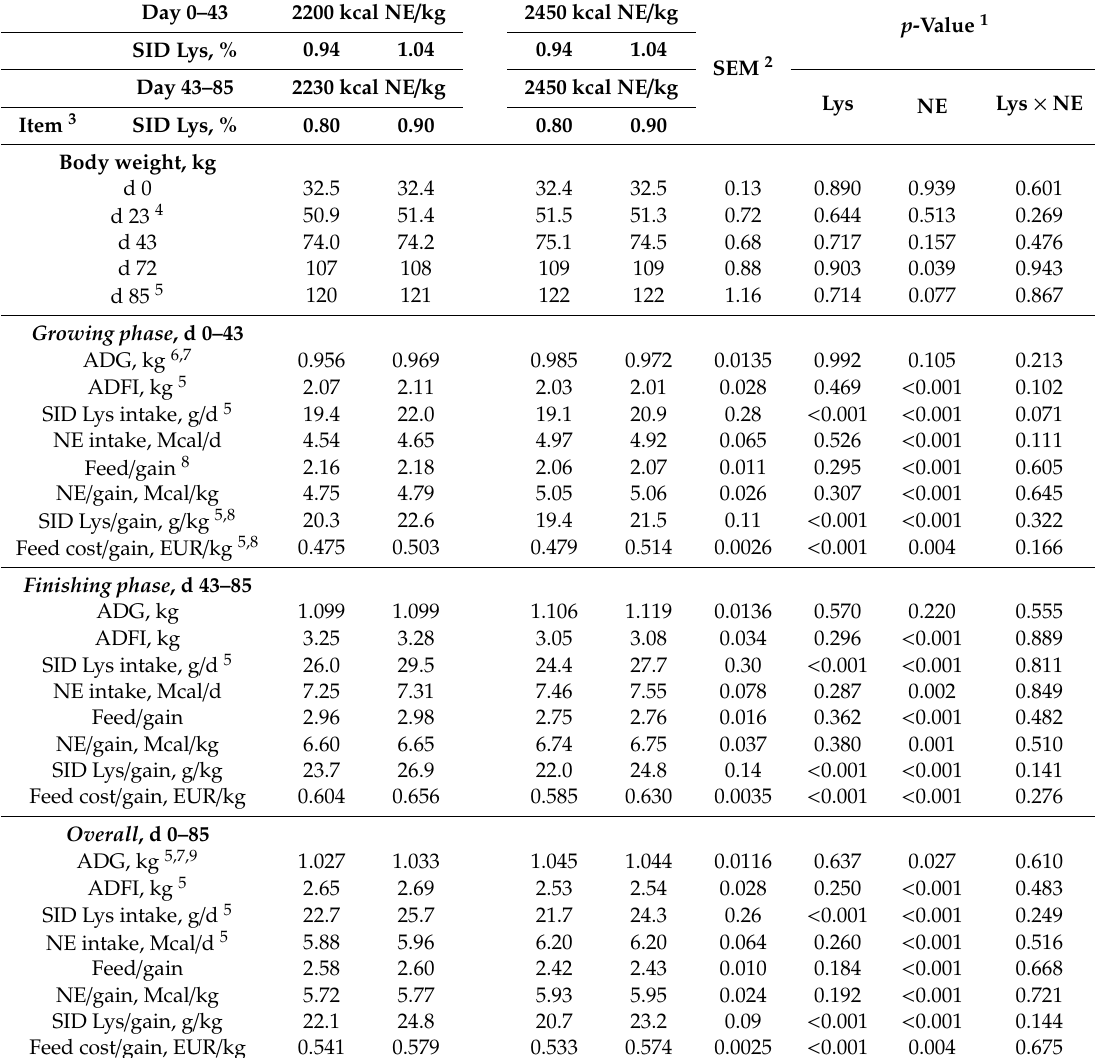
Table 4. E ff ects of increasing dietary standardized ileal digestible lysine (Lys) and reducing net energy (NE) concentration on growth performance of Duroc grow-finishing pigs (Experiment